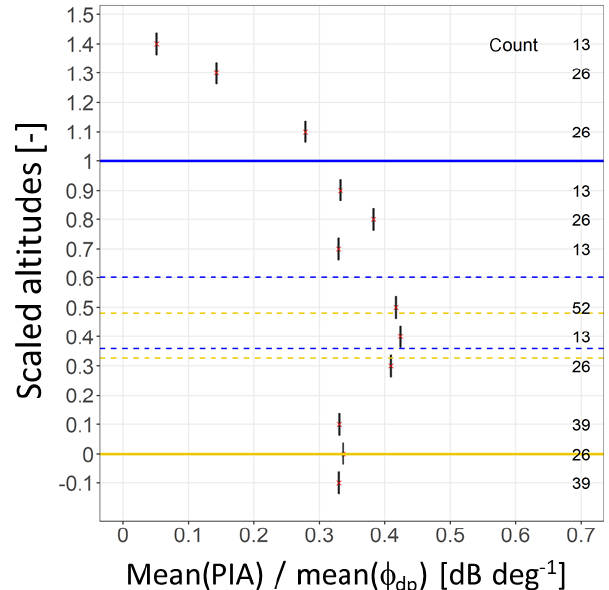
Figure 13. Evolution of the ratio of the mean PIAs over the mean ψ dp values within the ML as a function of the scaled altitudes for the stratiform event of 3–4 January 2018. The horizontal blue and orange lines represent the ML top and bottom, respectively; the bro- ken horizontal blue and orange lines give the 10% and 90% quan- tiles of the scaled altitudes of the Z h and ρ hv peak distributions,